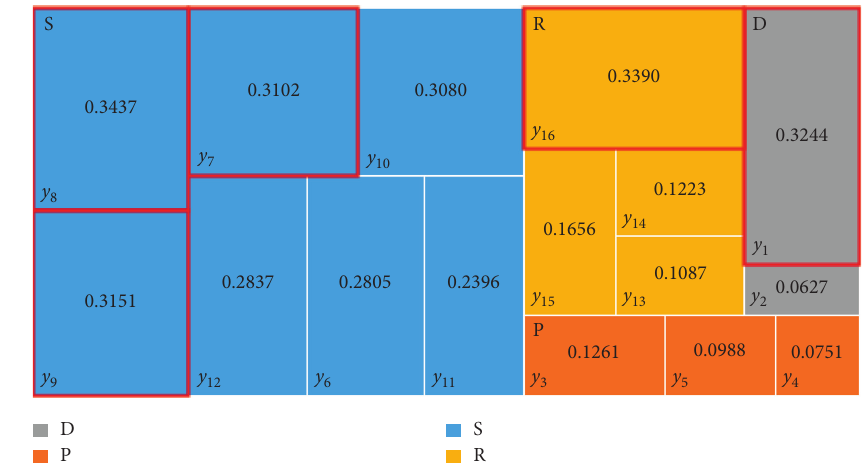
Figure 4: Projection vector ( a